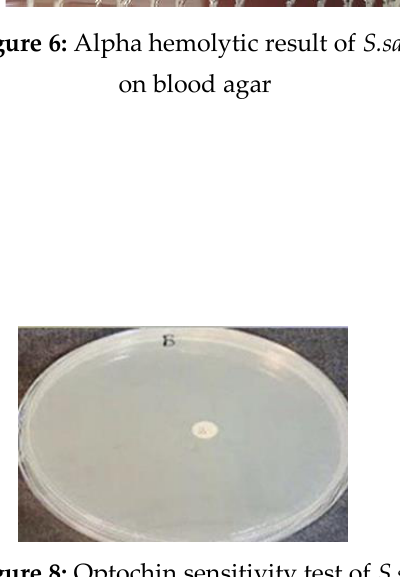
Figure 8: Optochin sensitivity test of S.sanguinis Figure 9: Amplification of S. sanguinis